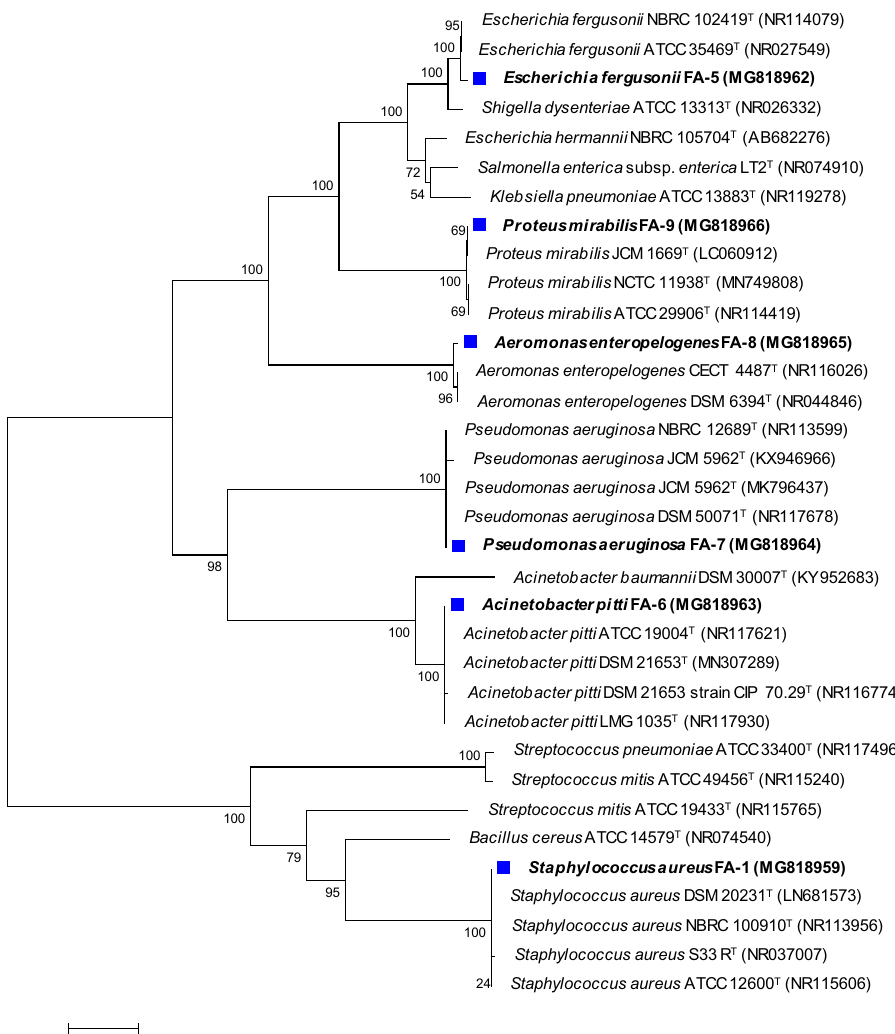
Figure 6. Unrooted neighbour-joined phylogenetic tree of isolated bacteria. The tree was constructed based on 16S rRNA partial gene sequence of bacterial isolates (marked with blue square) and closely related type species derived using NCBI BLAST search tool. Sequences were aligned using Clustal W sequence alignment tool in MEGA 7.0 software. The GenBank accession numbers of isolates and closely related species are placed in parenthesis. Bootstrap percentage values as obtained from 1000 replications of the data set are given at tree’s nodes. The scale bar corresponds to the mean number of nucleotide substitutions per